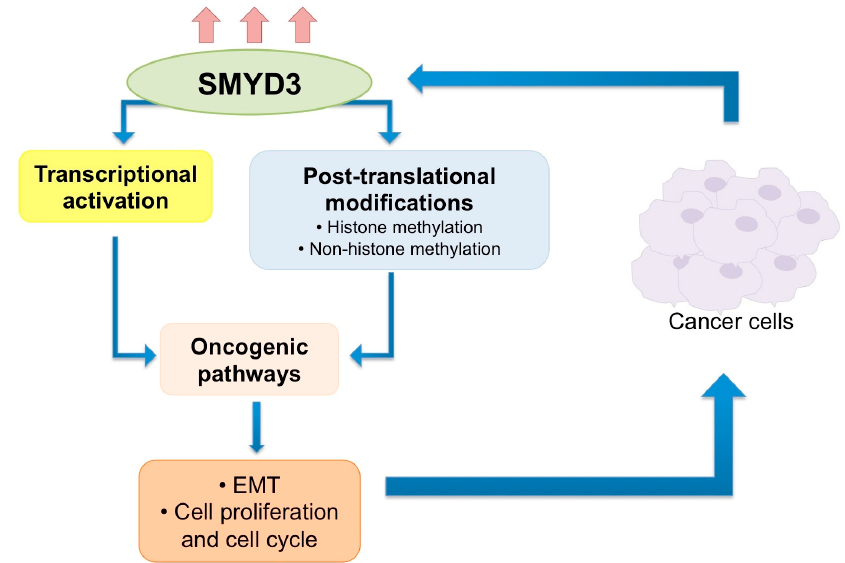
Figure 2. SMYD3-mediated activities that promote oncogenesis. SMYD3 is upregulated in cancer, where it promotes the activation of oncogenic pathways through two main functions, transcriptional activation of genes involved in cell proliferation and epithelial–mesenchymal transition (EMT), and through methylation of non-histone proteins, particularly involved in cell signaling, and resulting in increased cell growth and cell migration.